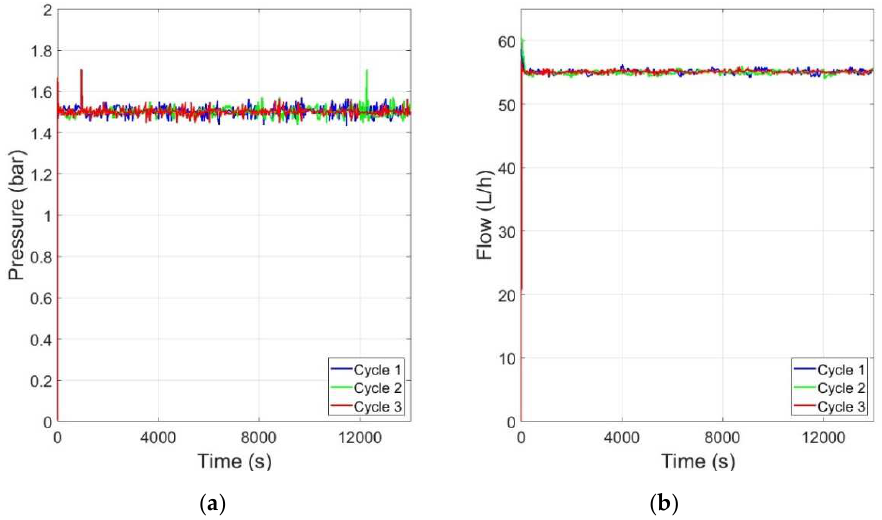
Figure 12. Controller performance in long time runs at the operation point (55 L/h, 1.5 bar): ( a ) operating point for pressure; ( b ) operating point for flow rate.